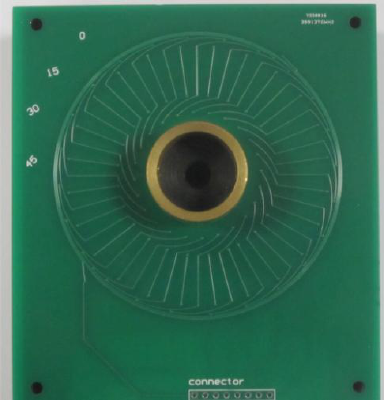
Figure 10. Enlarged view of the manufactured angle sensor.